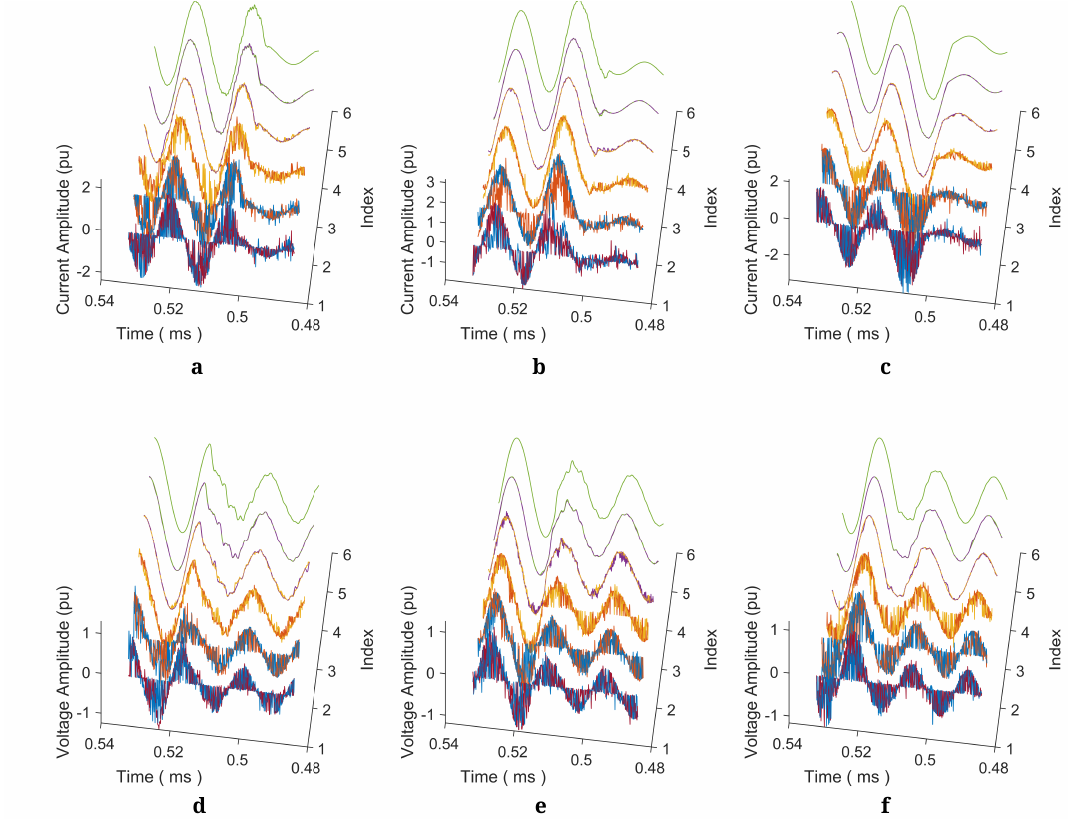
Figure 7. Signal reconstruction using k and m values vs. processing time (( a – c ) current and ( d – f ) voltage at bus